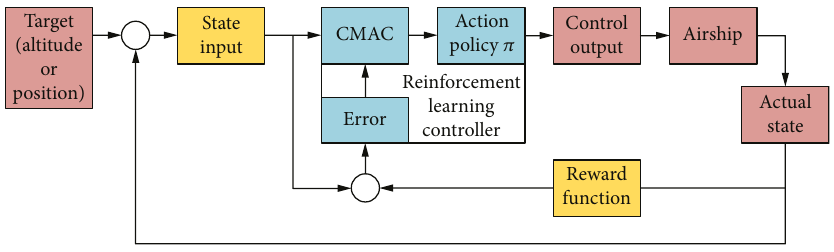
Figure 3: Structure of the airship reinforcement learning